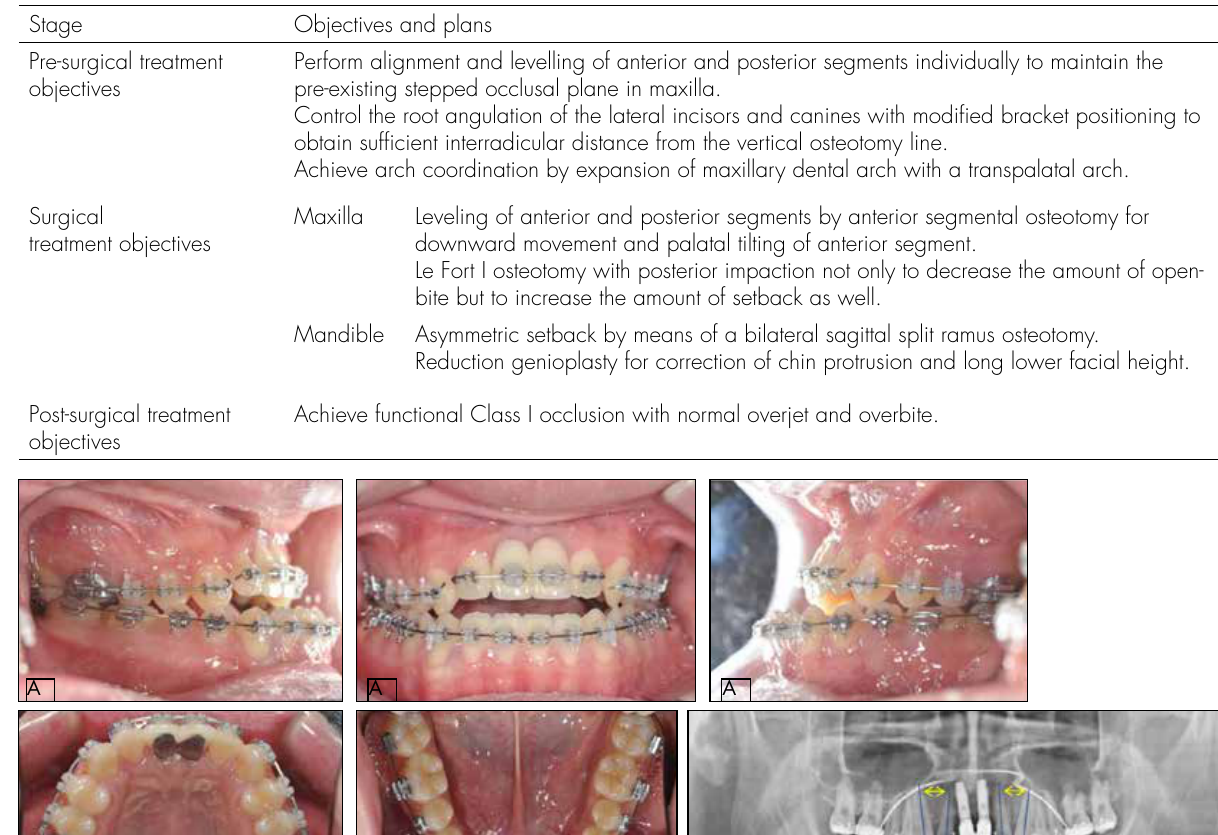
Table II. Treatment objectives and plans.